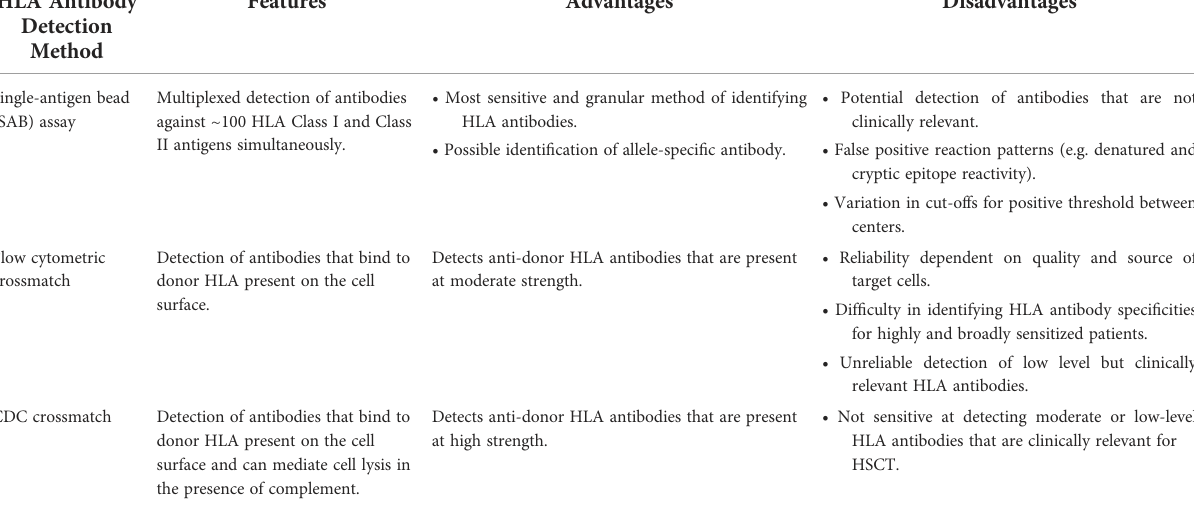
TABLE 1 Overview of methods used to detect donor-recipient compatibility and identify